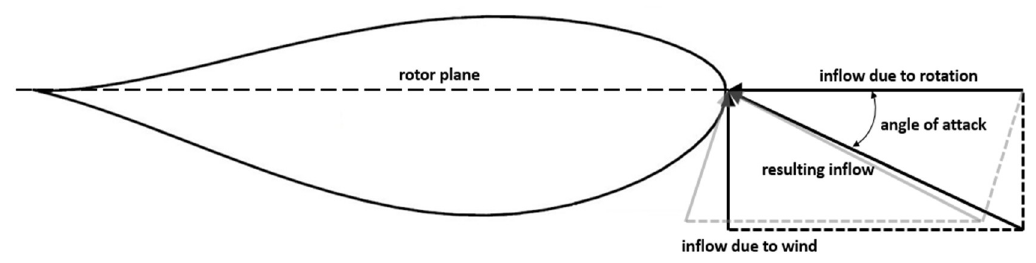
Figure 8. Schematic of the inflow conditions for a yaw misalignment of 0 ◦ (black lines) and a positive yaw misalignment (grey lines) for the blade elements of a blade at highest position.